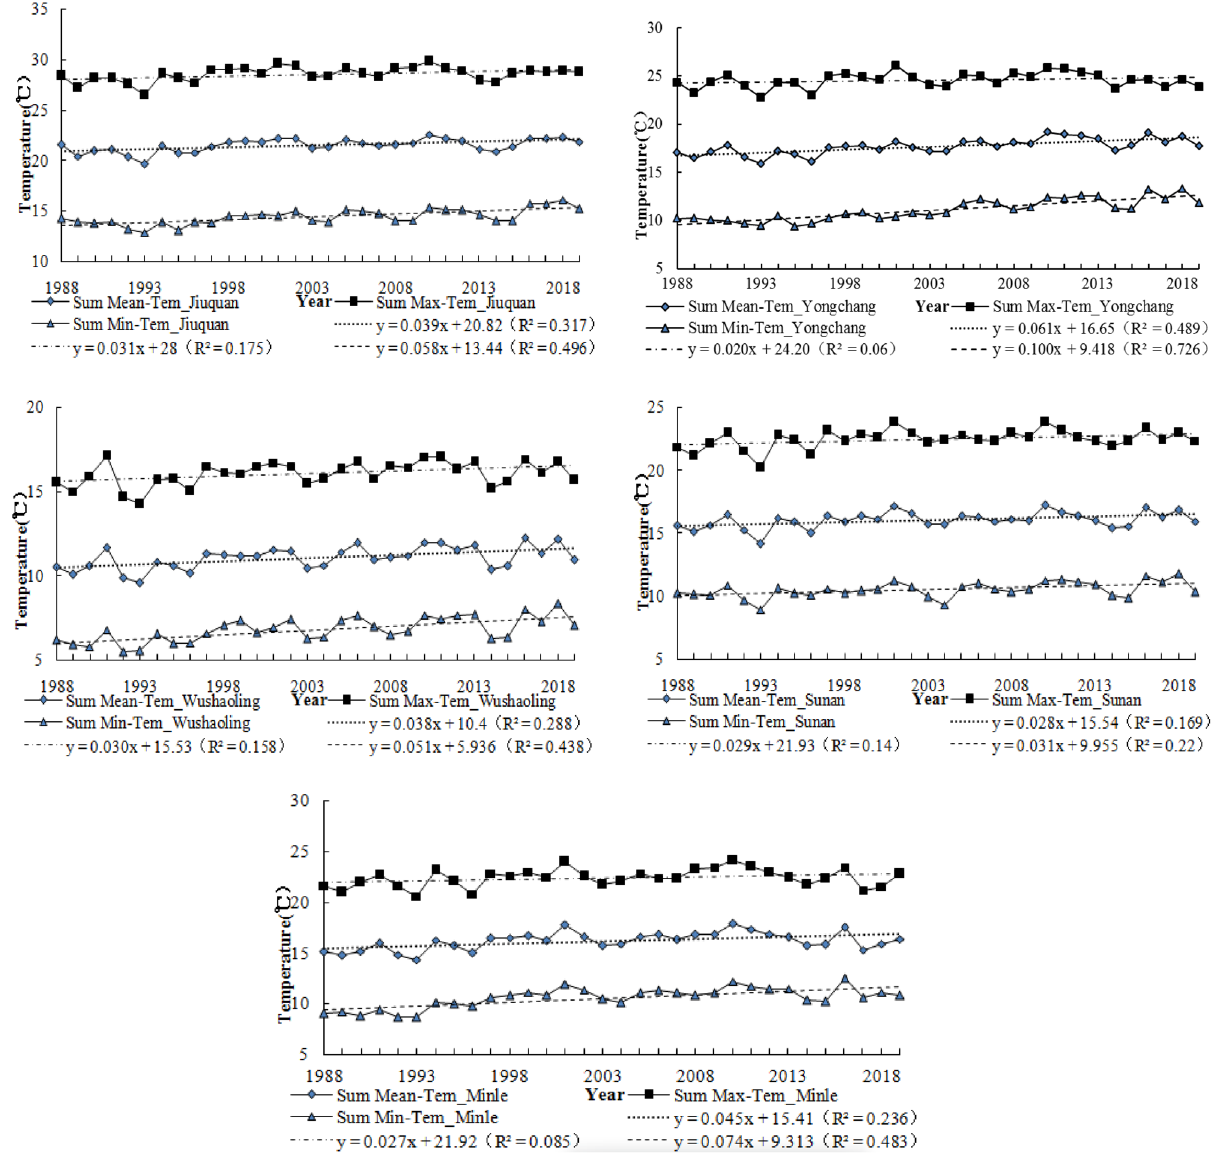
Figure 4. Trends of summer mean